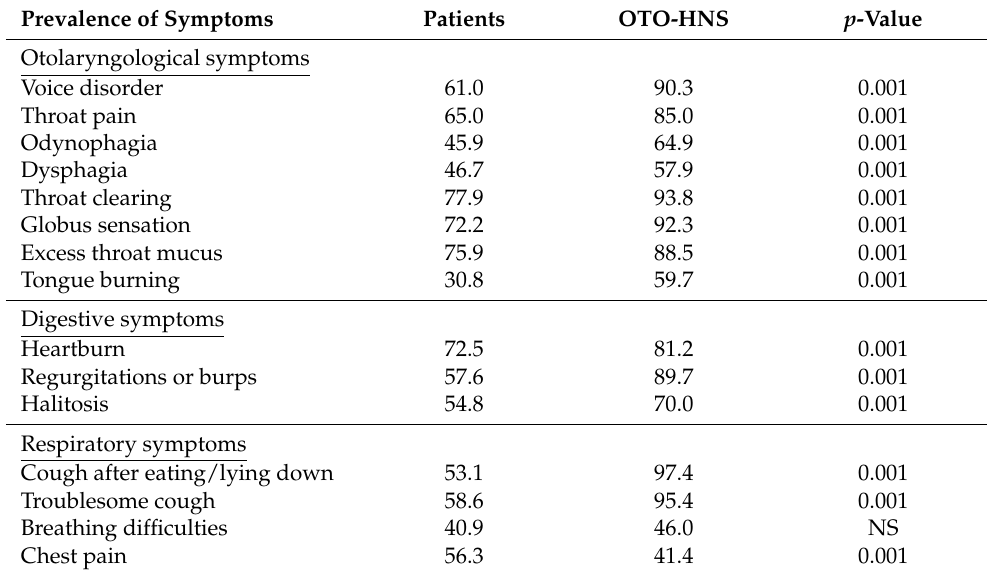
Table 2. Prevalence of symptoms according to patient cohort and otolaryngologists’ thoughts.